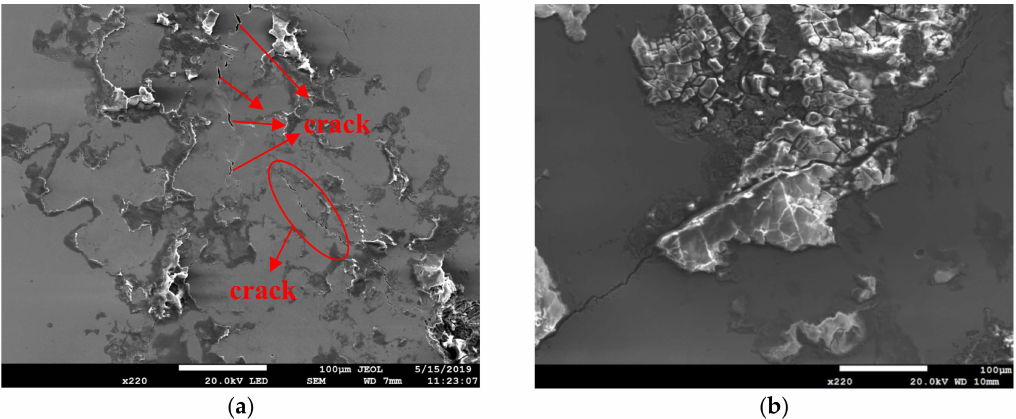
Figure 7. Stress corrosion cracking morphologies of specimens after 5000 h tests with 1 g / m 2 chloride concentration. ( a ) RH = 55%, and ( b ) RH =